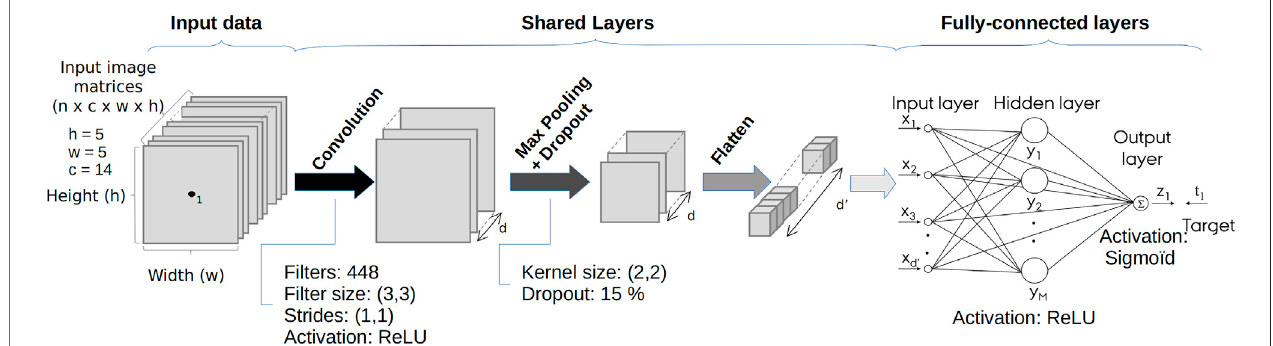
FIGURE 2 | Architecture of the selected